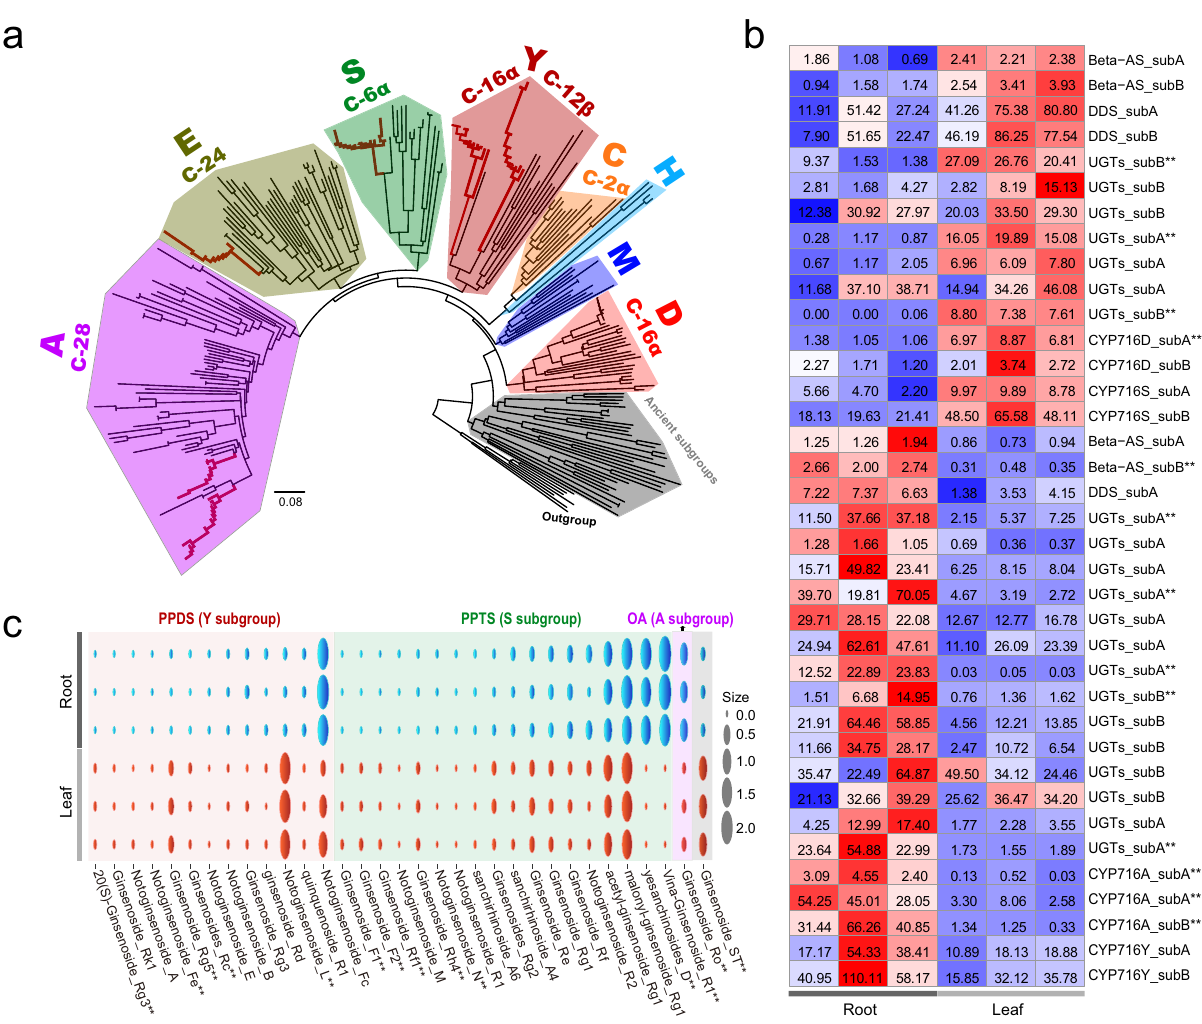
Fig. 5 Functional diversi fi cation of the CYP716 subfamily and triterpenoid biosynthesis genes. a Functional divergence of the subgroups in CYP716 subfamily. Each colored clade represents a subgroup that was derived from an ancestral CYP716 gene during polyploidization/diploidization processes. Branches marked with red color are Panax species. Oxidation and hydroxylation of the carbon positions are shown for each clade. b Expression divergence of the triterpenoid biosynthesis genes in root and leaf tissues. Numbers in the heatmap are the normalized gene expression levels based on transcriptome data. Name of each gene is shown on the right. The fi ve subgroups of CYP716 were derived from paleo-polyploidizations. The “ subA ” and “ subB ” originated by Pg- α . The other major genes involved in triterpenoid biosynthesis in ginseng species are also shown in the heatmap. c Metabolic analyses of the triterpenoid biosynthesis in ginseng root and leaf tissues. Name of each ginsenoside is shown at the bottom. Red, green and purple colors indicate the two dammarane and one oleanane type ginsenosides, respectively. The ginsenoside ST marked with gray color is unknown. **, indicates signi fi cant difference (Wald test) between the root and leaf tissues. Exact p values of these comparisons are shown in the Source Data fi